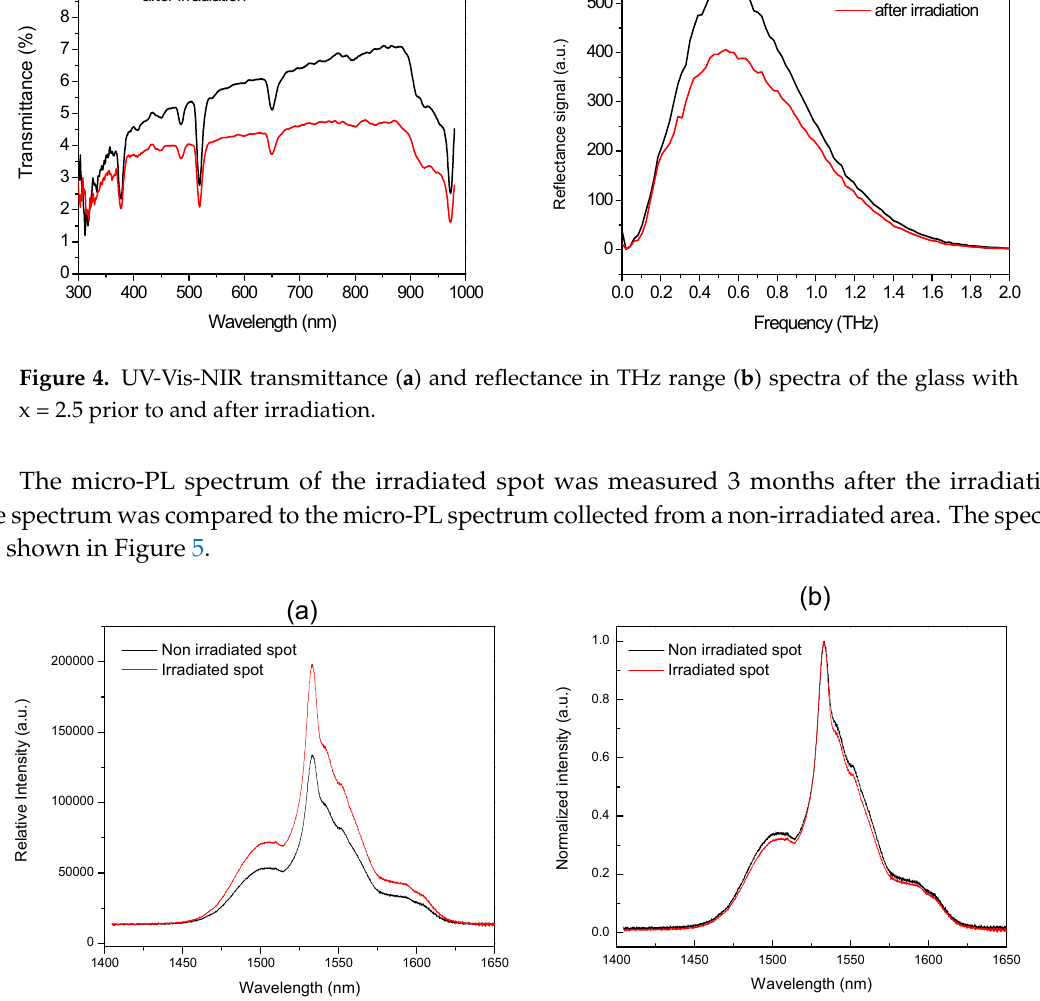
( b ) Figure 3. Image of spots at the surface of the glass ( a ) and its surface pro fi le ( b ) using Wyko NT1100 optical profiling system. We noticed that the increase in the surface roughness is a reversible process as it decreases